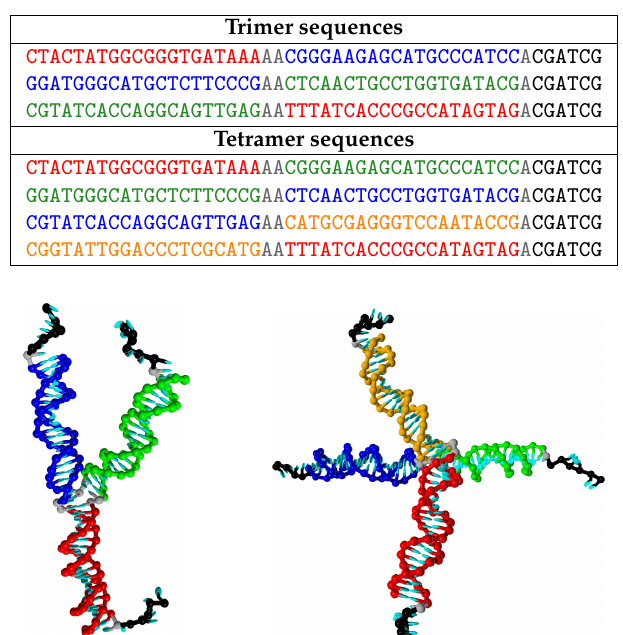
Figure 1. ( Top ) Strand sequences for the DNA constructs used in this work. Spacers (nucleotides that add flexibility to the structure but are not designed to pair up) are coloured in grey. Non-grey nucleotides that are part of complementary sequences share the same colour. ( Bottom ) Simulation snapshots of a trimer and a tetramer, coloured according to the same color